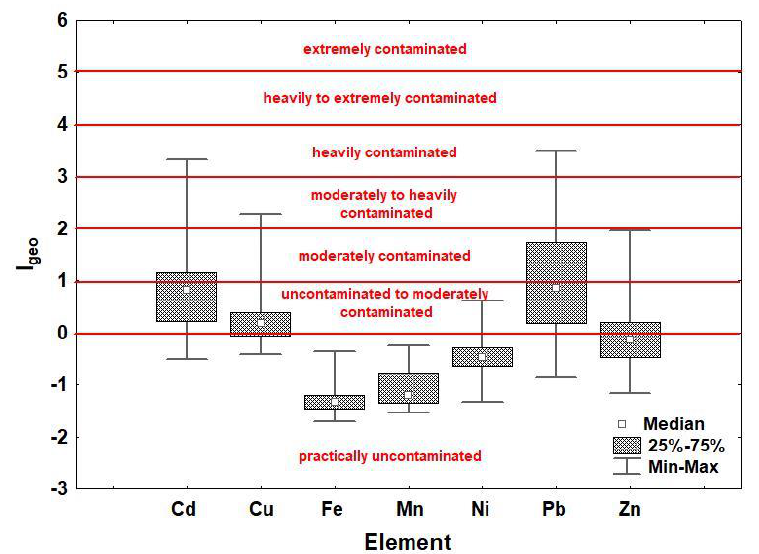
Figure 1. Geoaccumulation indices (I geo ) for the studied heavy metals (Cd, Cu, Fe, Mn, Ni, Pb and Zn) calculated in relation to the mean values of heavy metals in the region [59] with reported pollu- tion levels [60] for soils in the area of Varaždin (N Croatia) .